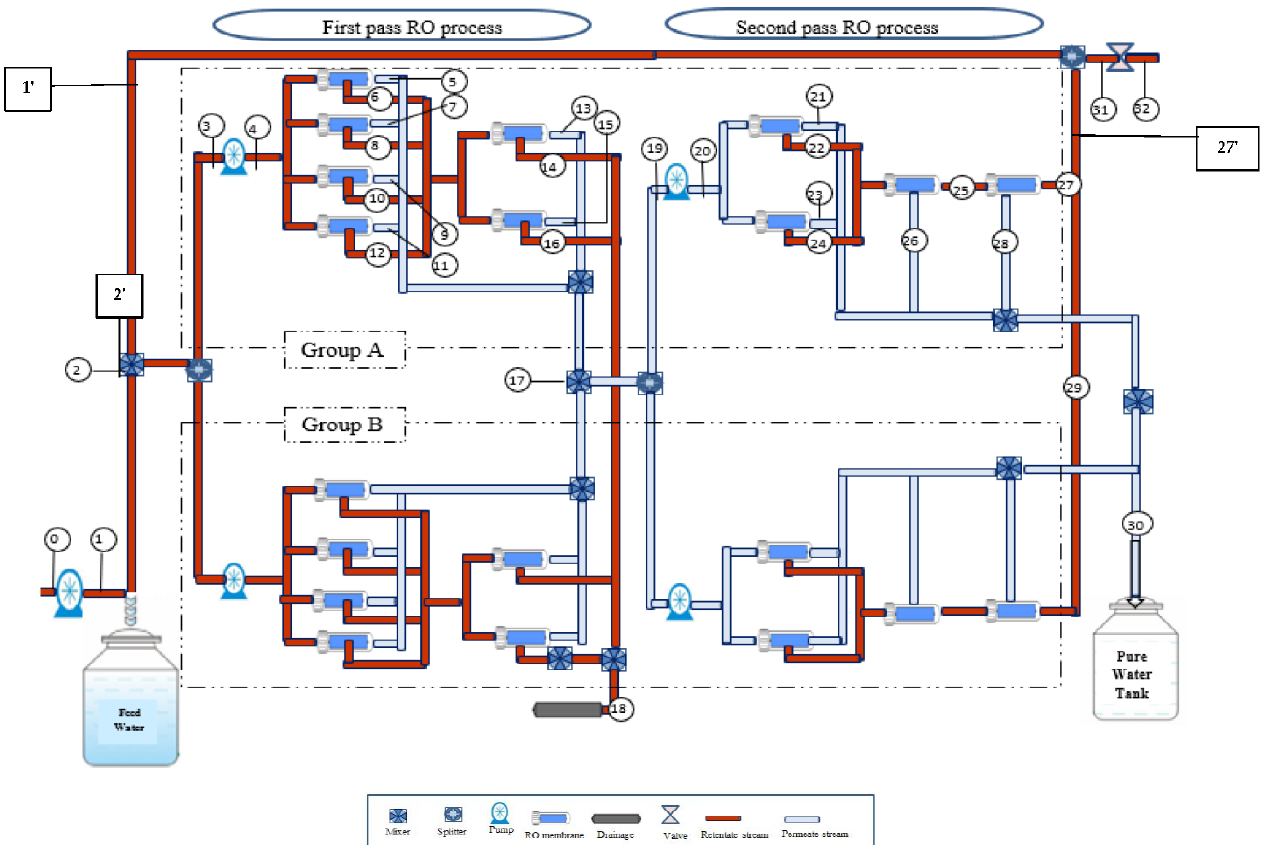
Figure 1. Flow diagram of the multistage RO brackish water desalination plant of the Arab Potash Company.